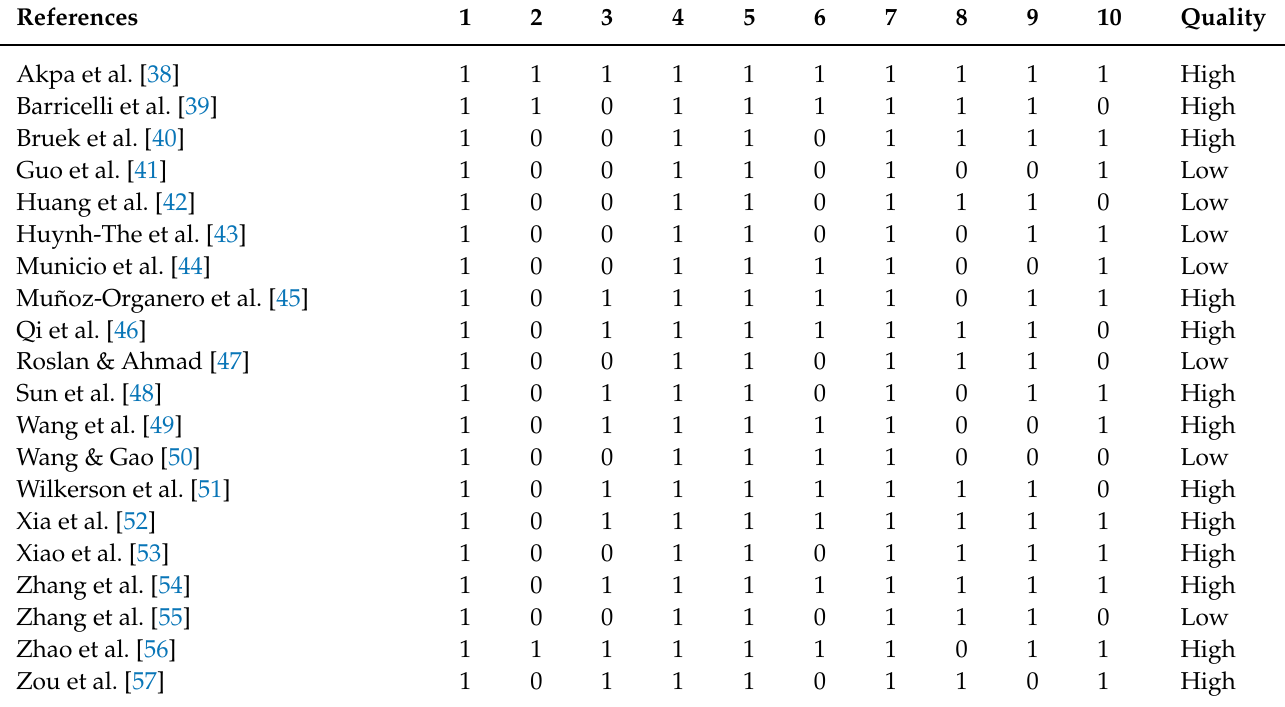
Table 2. Methodological assessment of the included